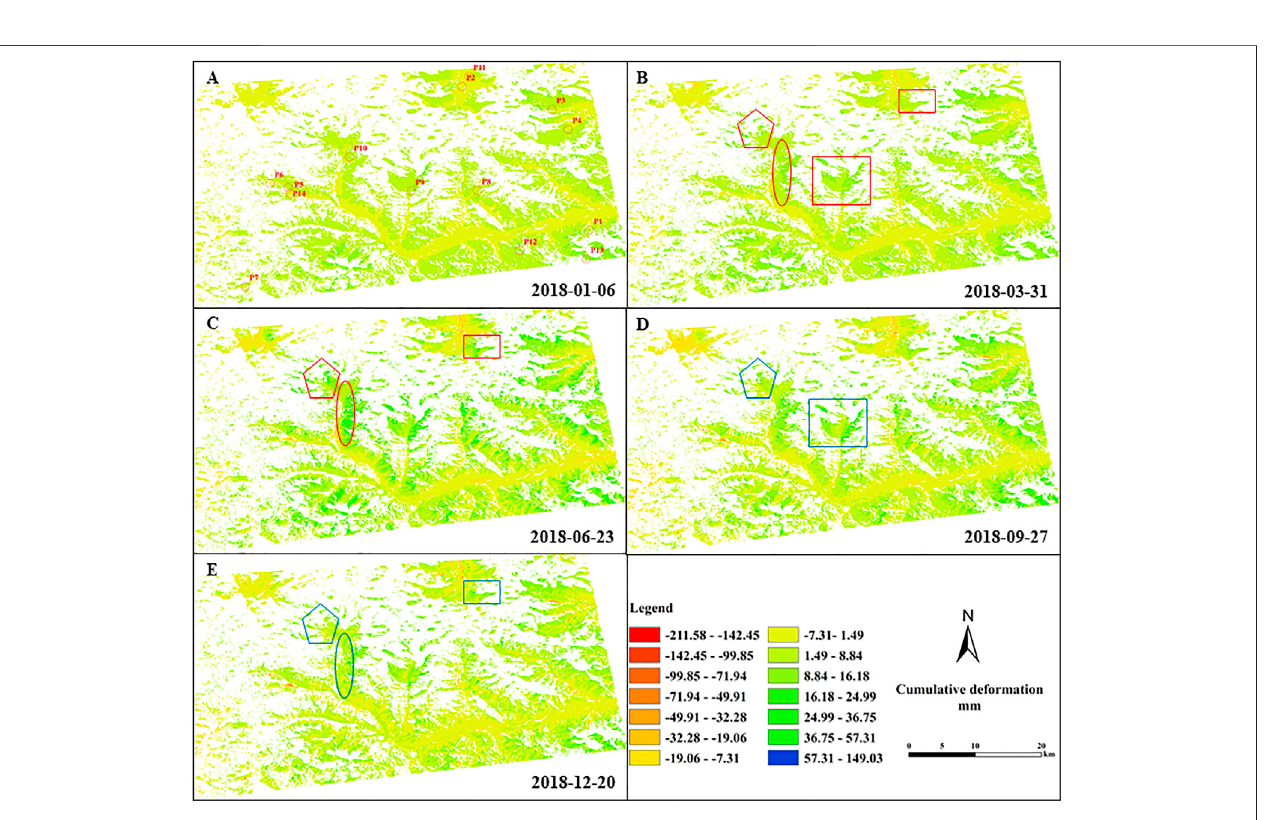
FIGURE5| Cumulativedeformation(mm)during2018[ (A – F) arethedatesof2018-01-06,2018-03-31,2018-06-23,2018-09-27,and2018-1220,respectively]. Thesmallredcirclesin (A) showtheareaswithevidentdeformationrate(14observations).Othergeometriclabelsindicateareasofsigni fi cantchange,withredindicating subsidence and blue indicating